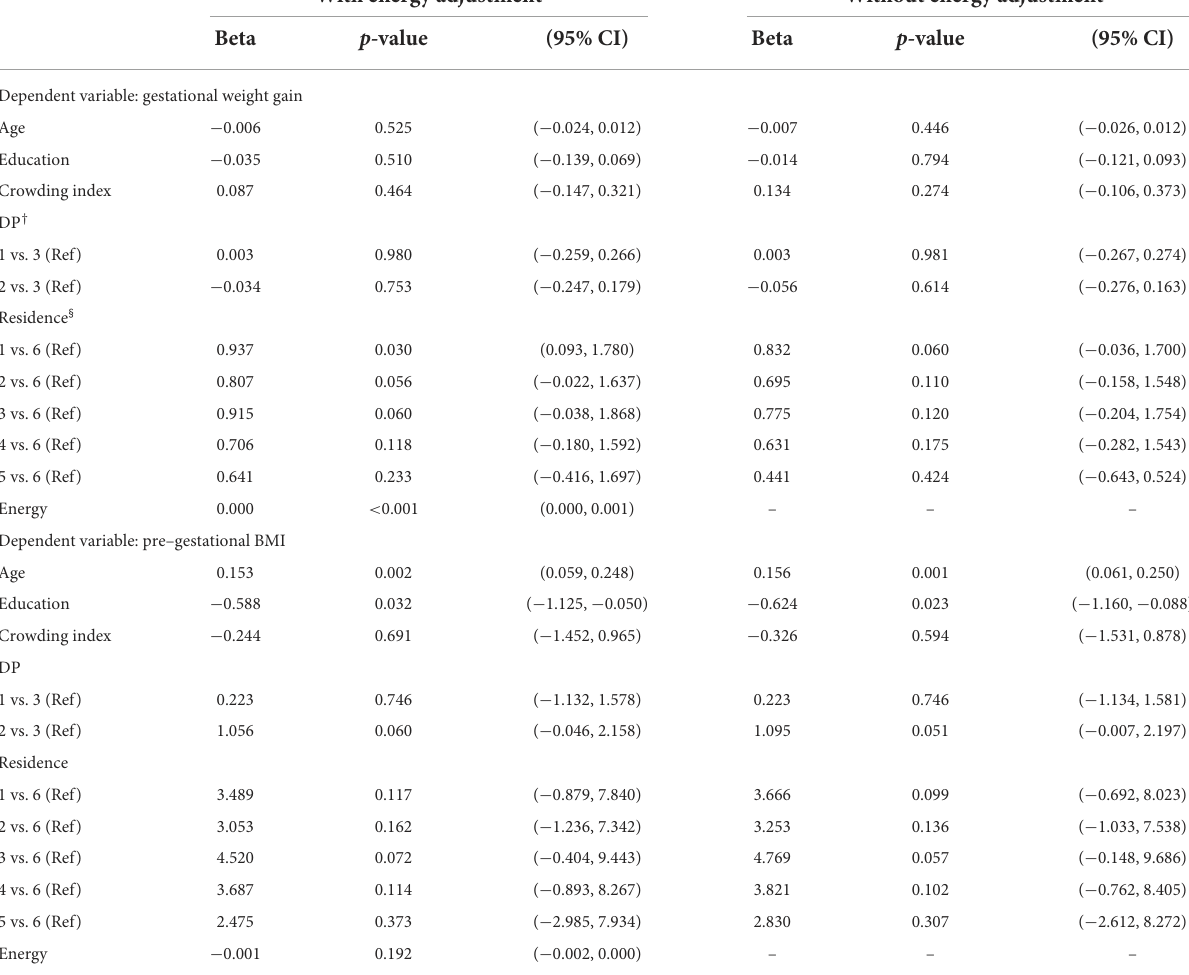
TABLE 8 Multivariate analysis of gestational weight gain and pre-gestational BMI of participants. With energy